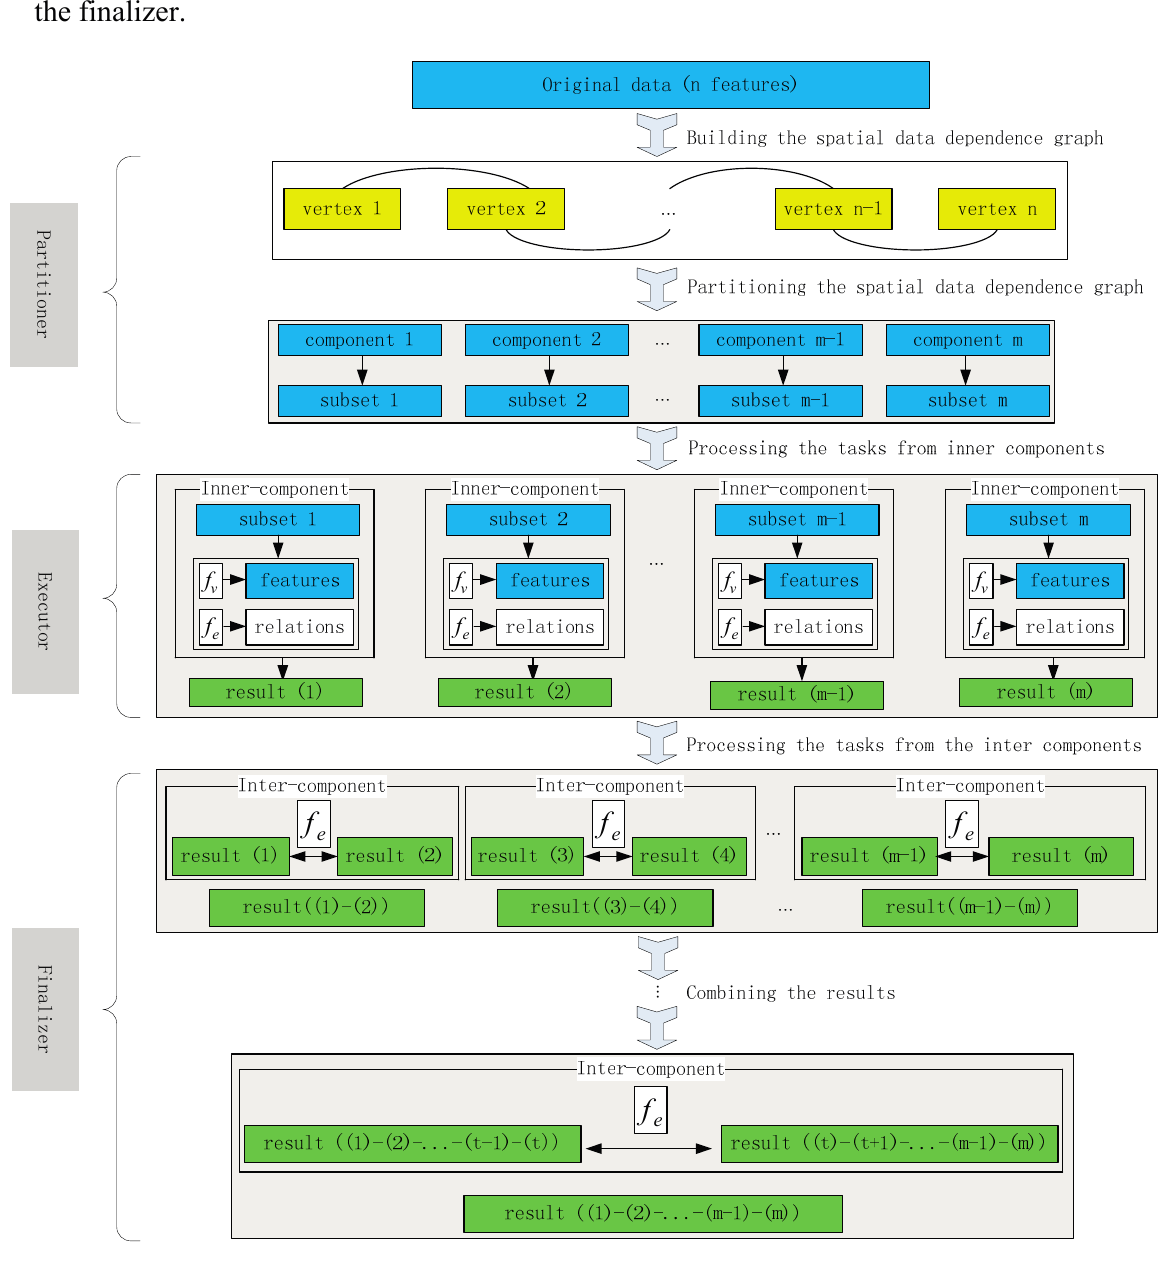
Figure 4. The scheduling engine for the thread-level kernel functions. The top-level layer is the task partitioner; the middle level layer is the executor; the bottom level layer is the